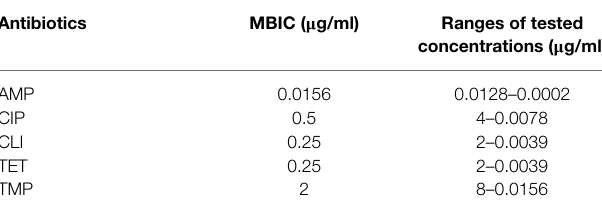
TABLE 1 | Minimum biofilm inhibitory concentration (MBIC) of S. aureus wood 46 and ranges of antibiotic solutions performed in the checkerboard biofilm formation